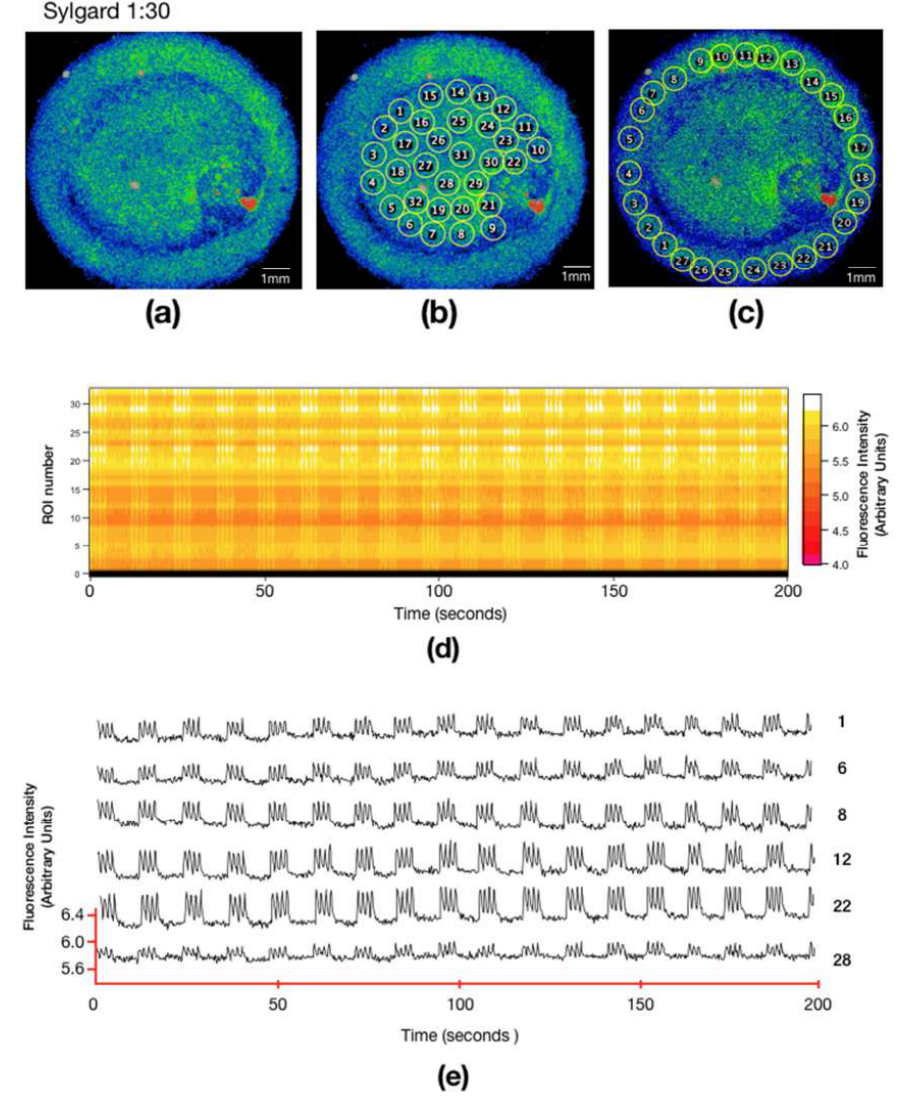
Figure 5. Embryonic cardiomyocytes cultured in soft PDMS ( a ) SD image corresponding to the cardiomyocytes cultured on proportion 1:30 of PDMS combination. Selection of regions of interest (ROI) from the optical recordings for the study over 200 seconds in the center of the ring ( b ) and in the ring channel ( c ). ( d ) Multicell (raster chart) summarizes the variations of Ca 2+ activity over the time of 40 ROIs. The ordinate axis represents the ROI number of the region marked in (b) (one ROI per row). The recording time is plotted on the abscissas, the intensity of the fluorescence for each region shown according to the color scale on the right side, the intensity is in arbitrary units (AU). ( e ) Activity profile from calcium fluorescence of six ROIs from the center of the ring.